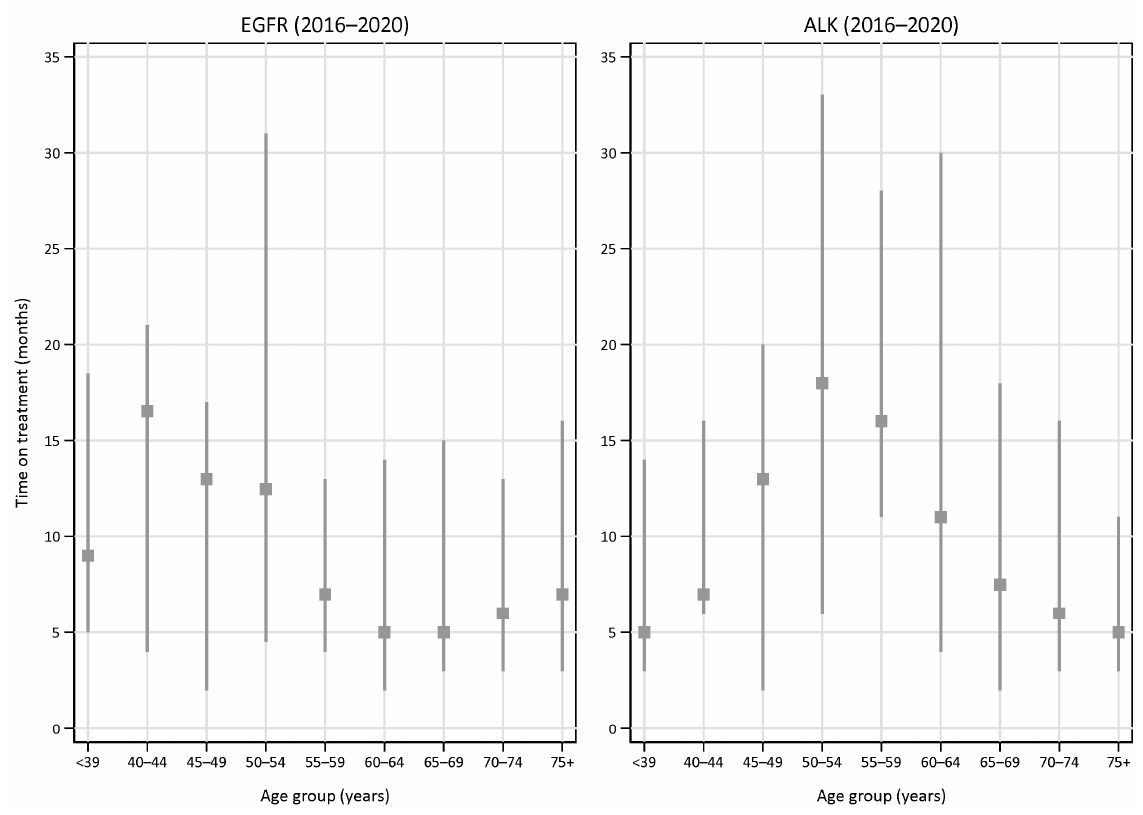
Figure 6. Median time on treatment (months)with EGFR-TKI (left panel) or ALK-TKI (right panel) in various age groups in the period 2016–2020. Error bars indicate interquartile ranges.